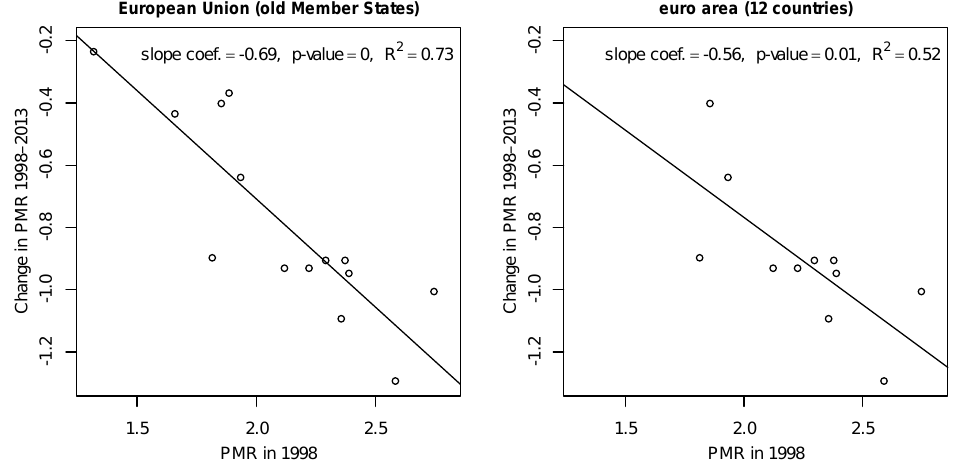
Figure 8 : β -convergence in product market